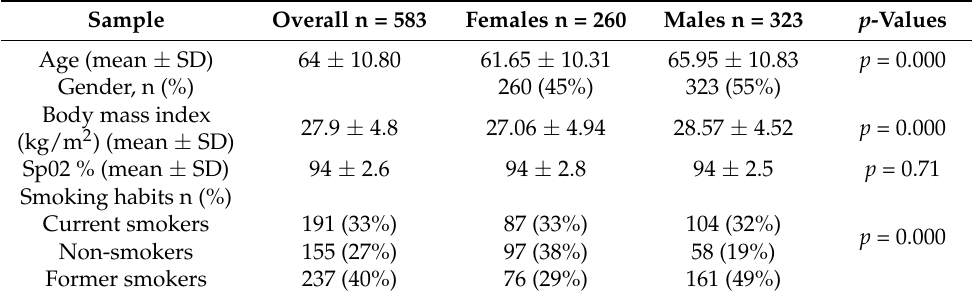
Table 1. Anthropometric and clinical characteristics of the study sample.